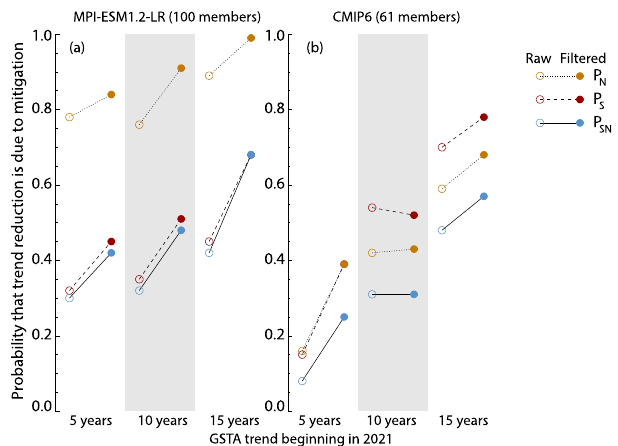
Fig. 6 Probabilities of causation of a reduction in global mean surface temperature anomaly (GSTA) trend, after a reduction in emissions. a A 100-member emulated ensemble based on MPI-ESM1.2-LR. b CMIP6. Colored symbols show the necessary ( P N ), suf fi cient ( P S ), and suf fi cient and necessary ( P SN ) probabilities, for raw (open symbols) and fi ltered (closed symbols) GSTA